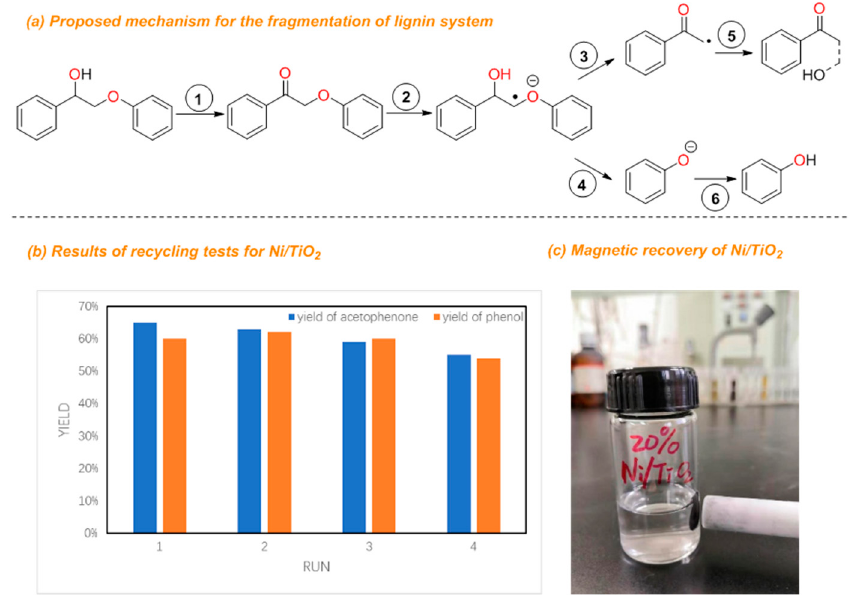
Figure 4. ( a ) Proposed mechanism for the two-step fragmentation of lignin systems. ( b ) Results of recycling tests for Ni/TiO 2 in the photocatalytic reaction, ( c ) magnetic recovery of Ni/TiO 2 after reaction.